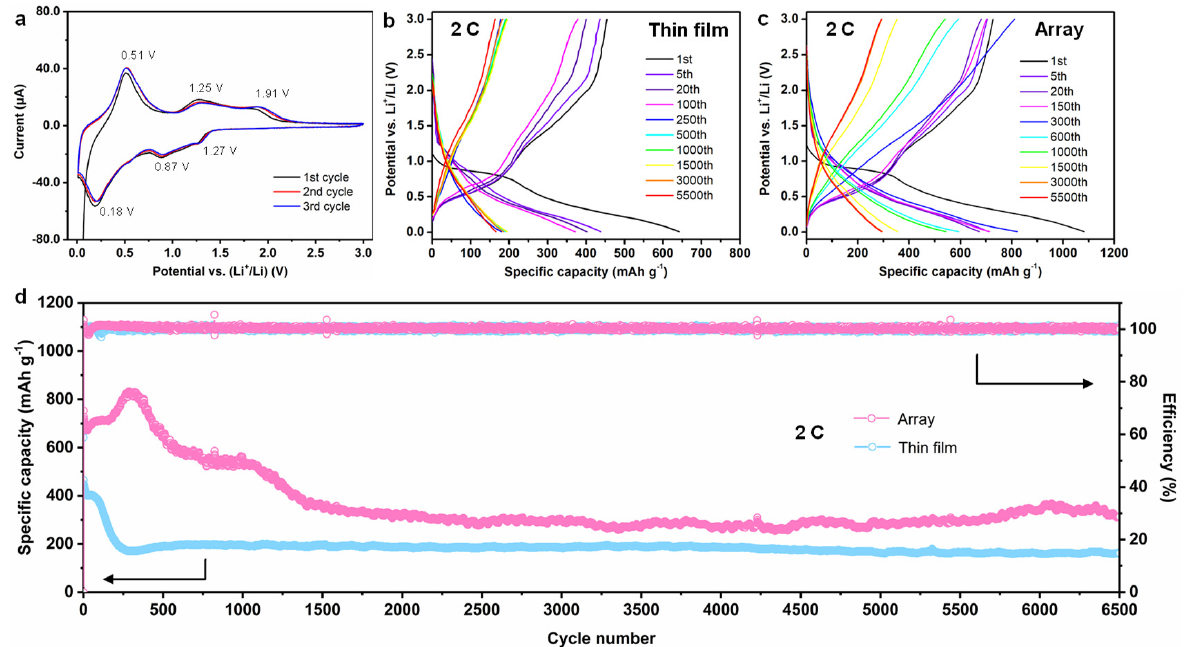
Figure 3. Electrochemical performance of SnO 2 electrodes. ( a ) CV curves of SnO 2 nanoarray at the scan rate of 0.2 mV s − 1 ; charge/discharge profiles of ( b ) PLD-fabricated SnO 2 thin film and ( c ) SnO 2 nanoarray anodes at the current density of 2 C; and ( d ) cyclic performance of PLD-fabricated SnO 2 thin film and SnO 2 nanoarray at the current density of 2 C.